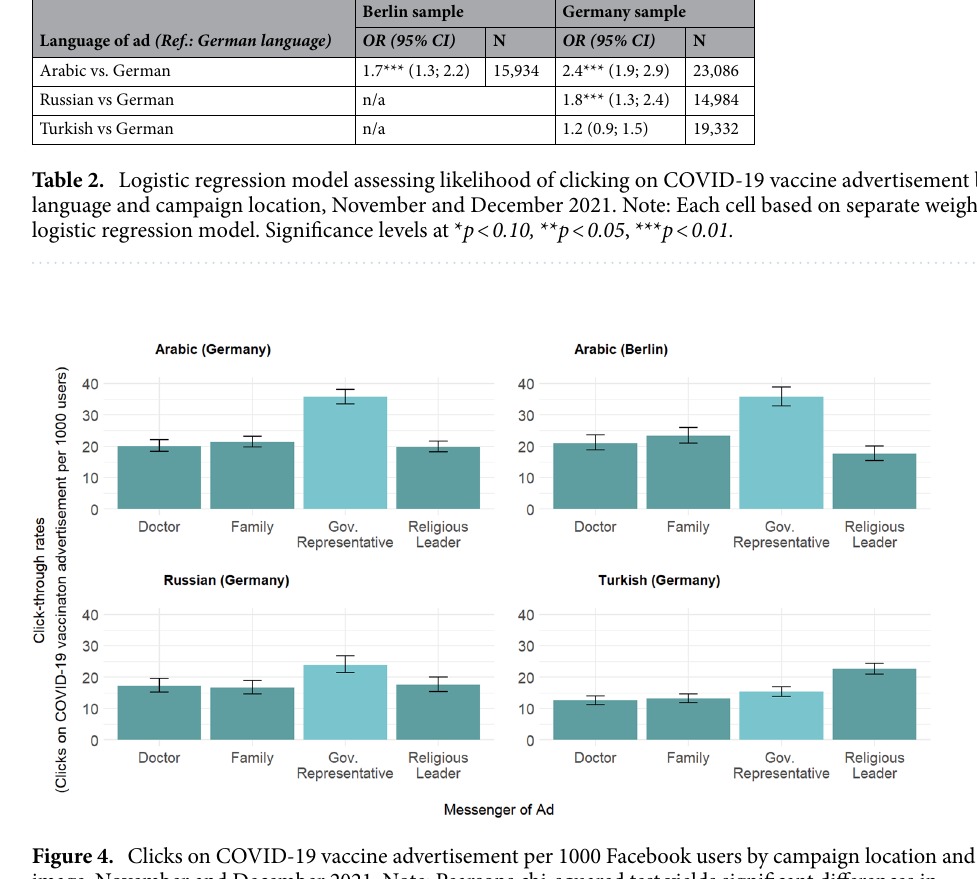
Language of ad (Ref.: German language)